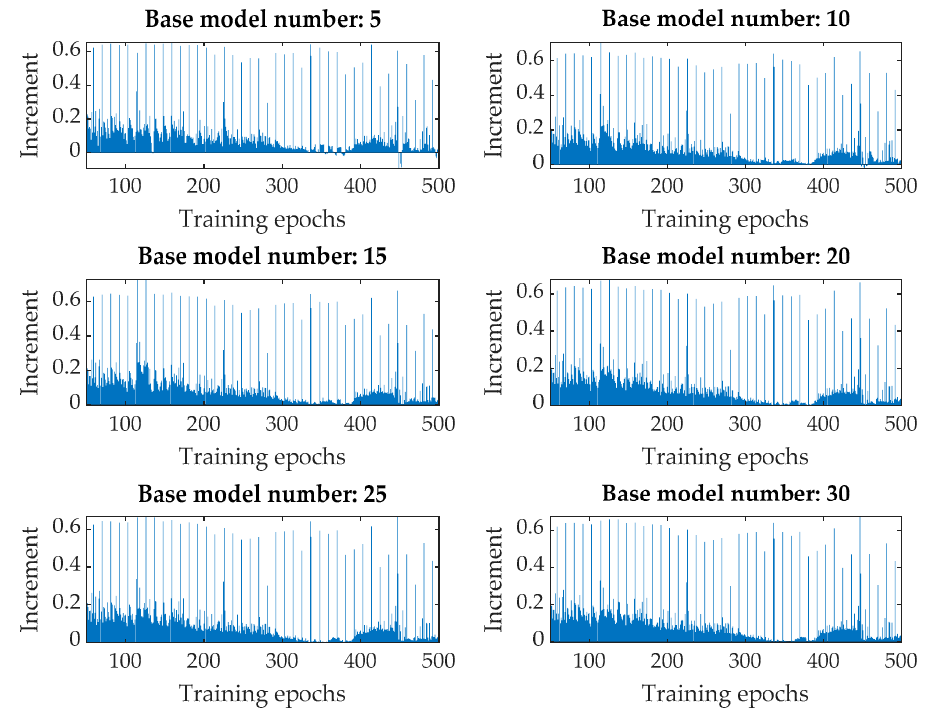
Figure 15. Quantitative analysis of increased accuracy after application of HSE.